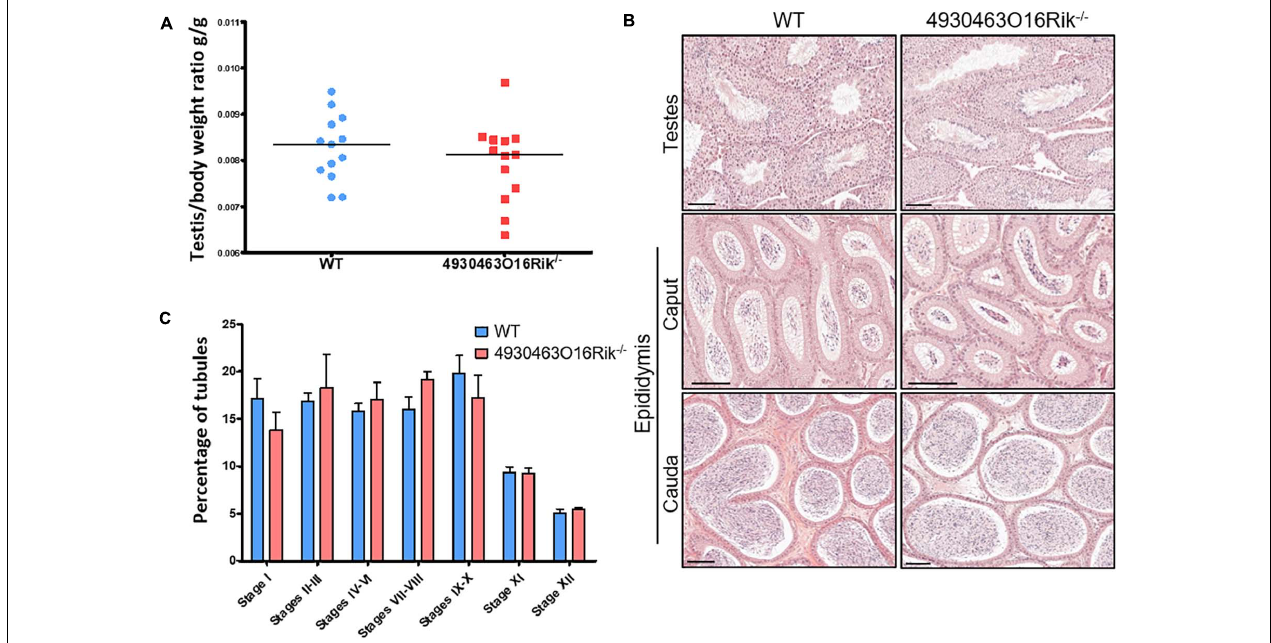
FIGURE 5 | Study of 4930463O16Rik − / − testicular phenotype. (A) Testis/body weight ratio of 8-week-old mice. No significant difference was observed in the two mouse lines. Median lines are in black. (B) Hematoxylin and eosin (HE) staining of testis and epididymis sections from WT and 4930463O16Rik − / − 8-week-old mice. Scale bar = 50 µ m. Spermatozoa were visible in the lumen of the testes and epididymis of WT and 4930463O16Rik − / − mice. (C) Quantification of the different seminiferous epithelium stages in WT and 4930463O16Rik − / − 8-week-old mice. No significant difference was found between WT and 4930463O16Rik − / −